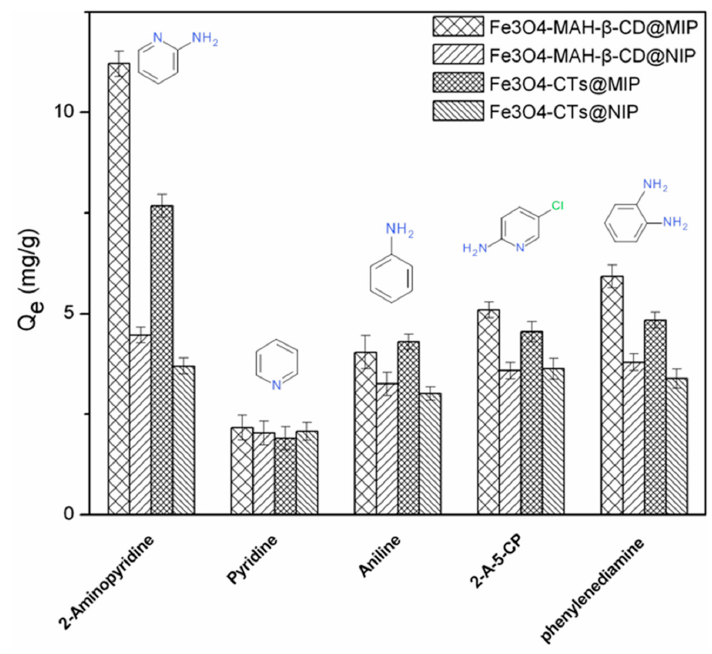
Figure 11. Binding selectivity of Fe 3 O 4 -CTs@MIP and Fe 3 O 4 -MAH- β -CD@MIP.